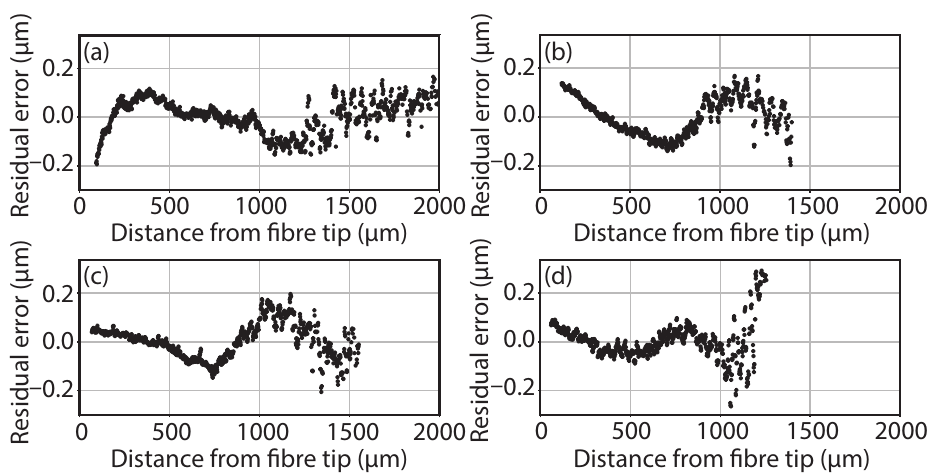
Figure 3. Residual errors from a 1st order polynomial fit to LCI captured readings versus Renishaw XL-80 readings across measured offset range, in ( a ) air, submerged sample/fibre tip in ( b ) paraffin oil, ( c ) water and ( d ) MWF.